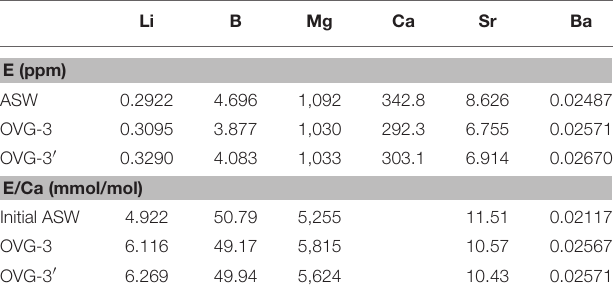
TABLE 3 | Elemental composition of artificial seawater (Instant Ocean) and final